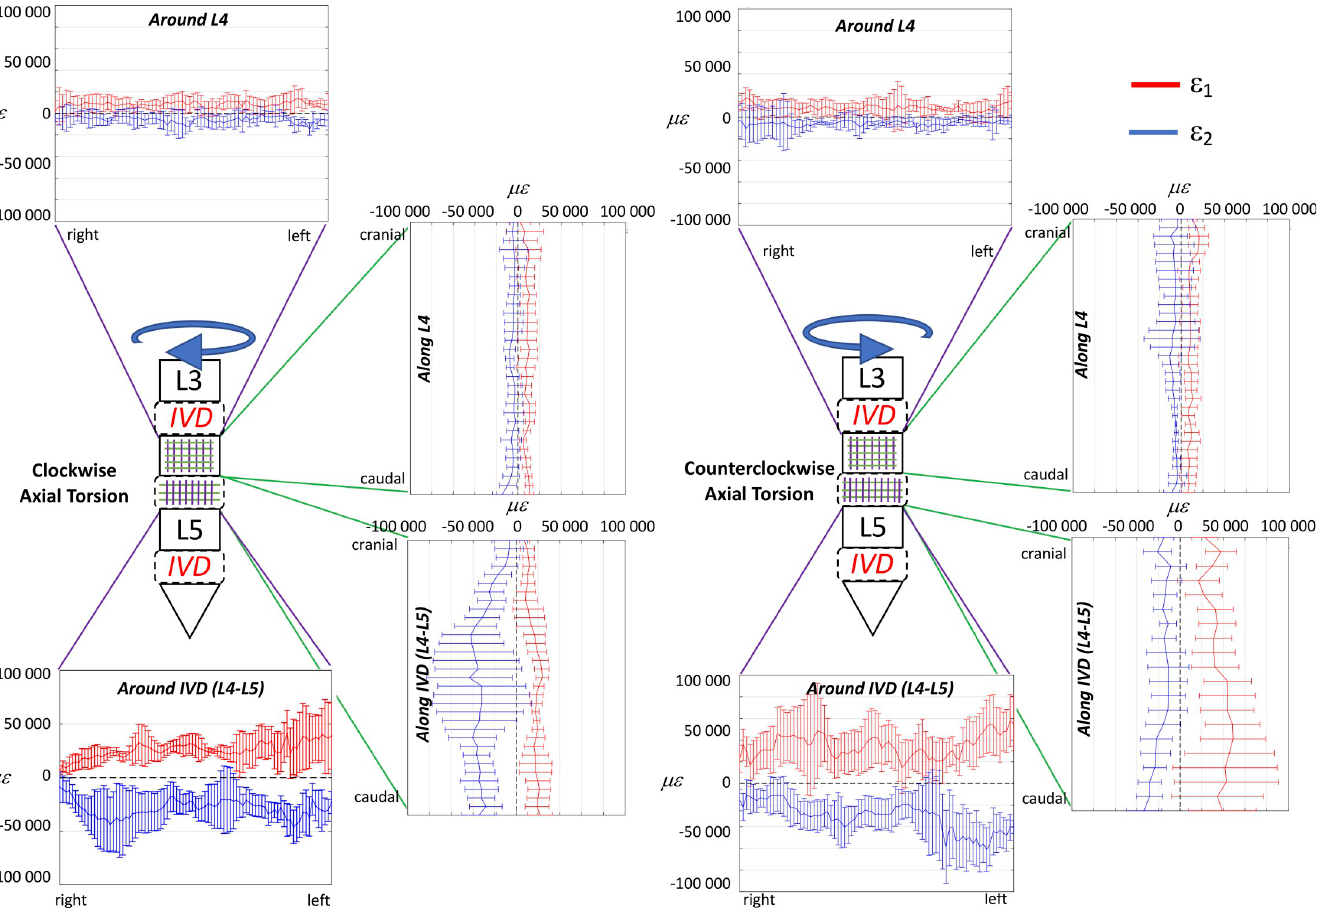
Fig 7. Axial Torsion at the maximum loading (7.5 Nm): to describe the strain distribution of the ALL in the circumferential direction, the median over cranio- caudal lines were computed in the sub-ROI in front of the L4 vertebra and in the sub-ROI in front of the L4-L5 IVD. Similarly, to describe the strain distribution of the ALL in the cranio-caudal direction, the median over circumferential lines were computed in the sub-ROI in front of the L4 vertebra and in the sub-ROI in front of the L4-L5 IVD. The plots show the distribution of eps 1 (red) and eps 2 (blue) circumferential direction of the L4 and the IVD (purple lines) and in the cranio-caudal direction of the L4 and the IVD (green lines). The median and standard deviation within the five specimens are reported.